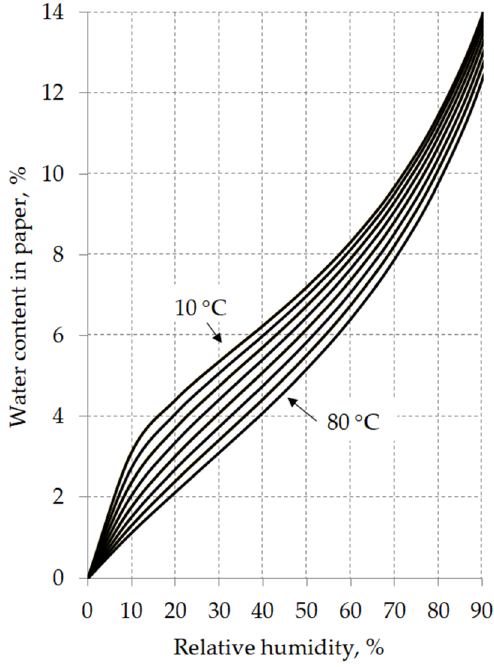
Figure 10. Water sorption isotherms of cellulose paper, based on the data from [32].